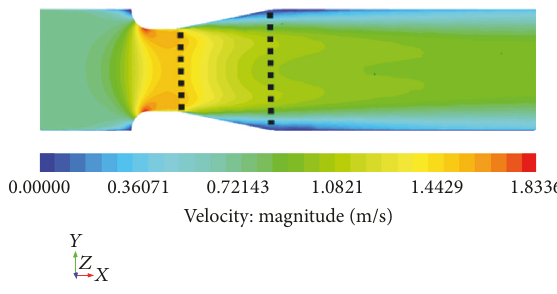
Figure 15: Long diffuser geometry and its velocity